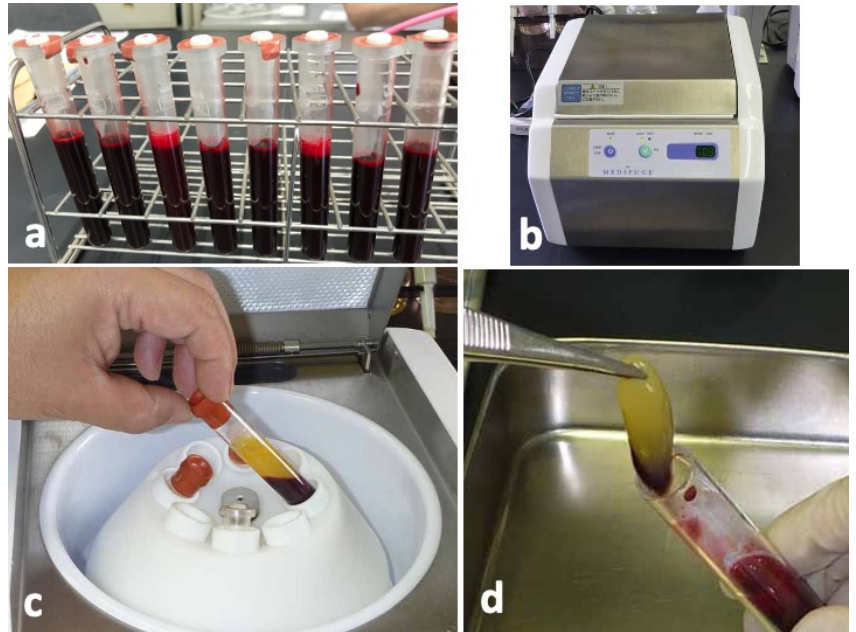
Figure 6. Preparation of concentrated growth factor (CGF) glue. ( a ) Venous blood in vacuum glass tubes, ( b ) Centrifuge machine (Medifuge ® , Silfradent Srl, Forli, Italy) used for preparation of CGF glue, ( c ) Blood fractions just after centrifugation, ( d ) Middle layer (CGF glue) showing yellow glue with a small amount of red layer (buffy coat).